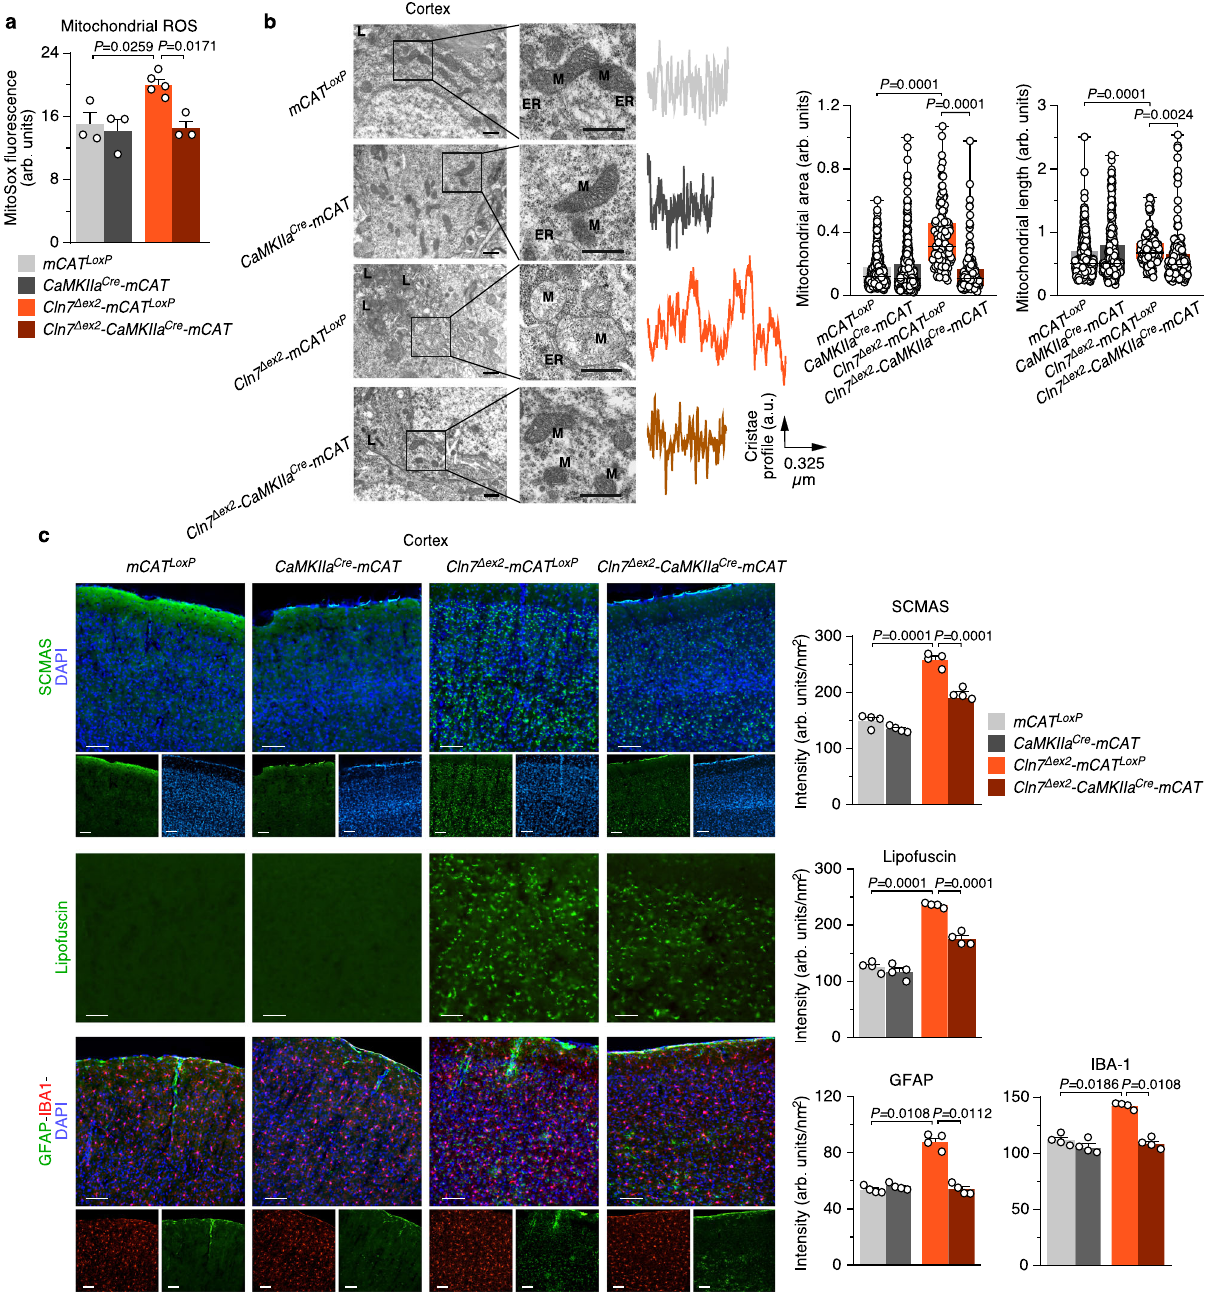
Fig. 2 Increased generation of mitochondrial ROS by neurons accounts for impaired mitochondrial accumulation and hallmarks of CLN7 disease in Cln7 Δ ex2 mouse in vivo. a Mitochondrial ROS analysis in primary neurons from the designed genotype. Data are mean ± SEM from n = 3 or n = 5 ( Cln7 Δ ex2 - mCAT LoxP ) independent experiments. b Representative electron microscopy images of the mouse brain cortex displaying the cristae pro fi le plot of intensities over the maximal axis of the magni fi ed shown mitochondrion (left) and the analyses of mitochondrial area and length (right). Data are in box plots (the box extends from the 25th to 75th percentiles, the horizontal line indicates the median, and the whiskers go down to the smallest value and up to the largest) from n ≥ 136 mitochondria per condition of 3-month-old mice. Scale bars, 600 nm. (M mitochondria, L lysosome, ER endoplasmic reticulum). c Representative images of SCMAS, lipofuscin, GFAP and IBA-1 immunohistochemical analysis of the mouse brain cortex. Data are mean ± SEM from n = 4 animals of 3-month old (three serial slices per mouse). Scale bar, 100 µ m. Statistical analyses were performed by one-way ANOVA followed by Tukey ’ s post hoc test. See also Supplementary Fig. 2. Source data are provided as a Source Data fi